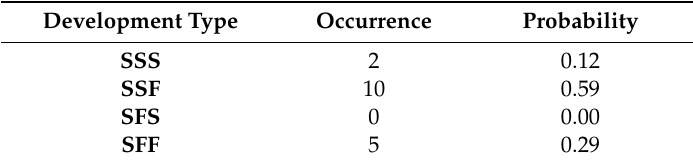
Table 1. Inter-annual development types for three main spawning events (S: slow initiation phase, F: fast initiation